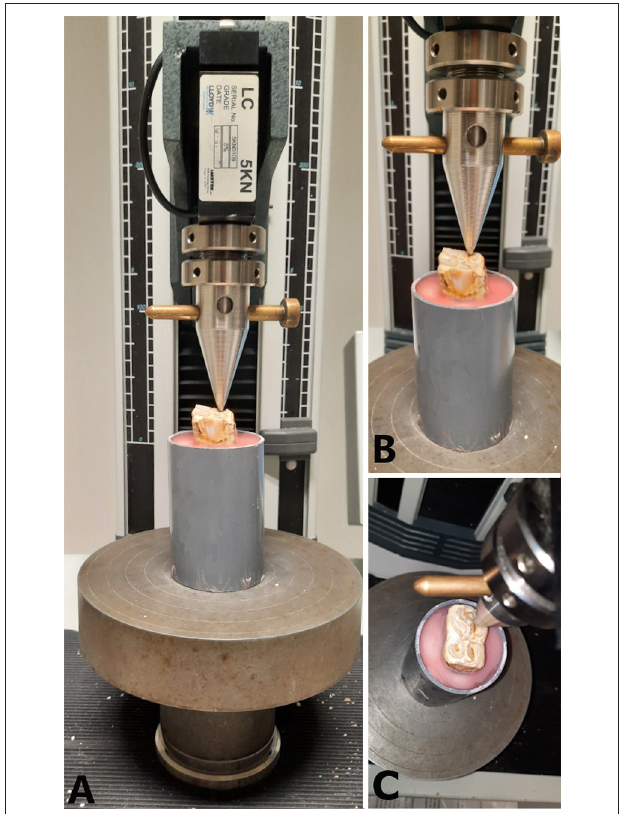
FIGURE 3 | Representation of the application of a compressive force to the occlusal surface of a mandibular cheek tooth at the level of the secondary dentine above pulp horn 2. (A) Frontal view of the specimen placed under the compression device attached to a 5,000N load cell. (B) Close up of the front view centered on the tooth. (C) Dorsal view of the positioning of the compression